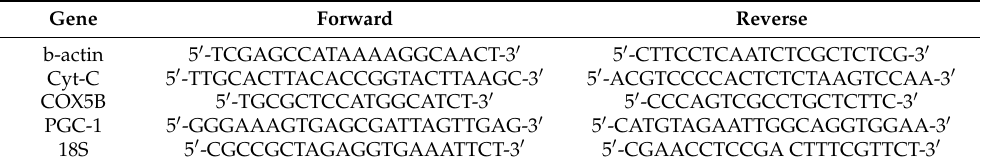
Table 1. Primer sequences for